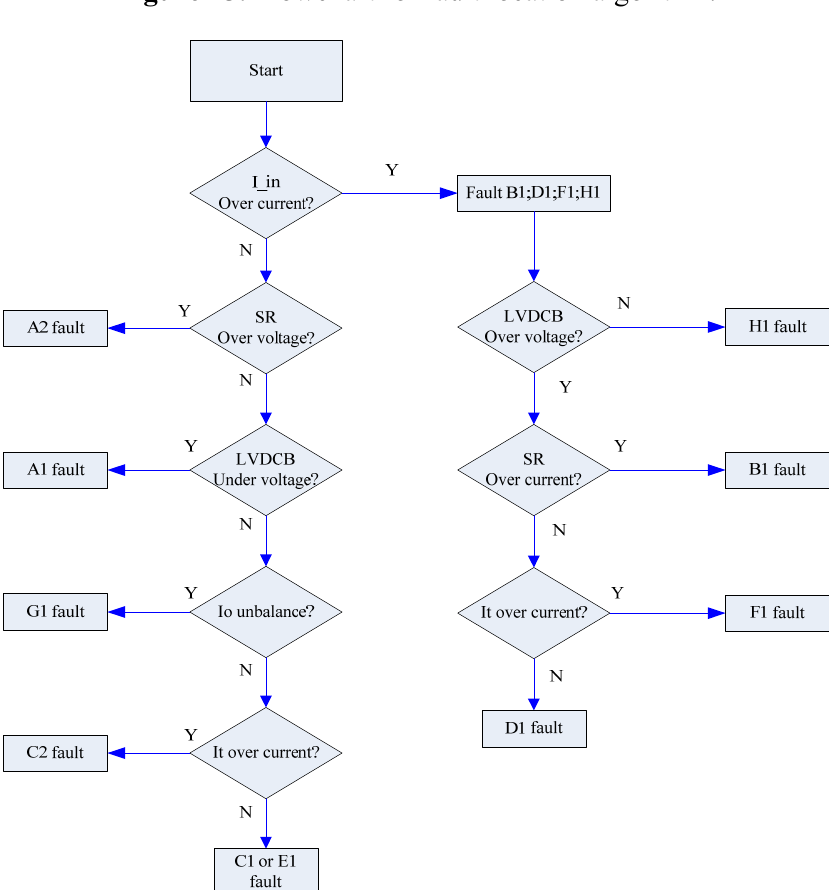
Figure 23. Flowchart for fault location